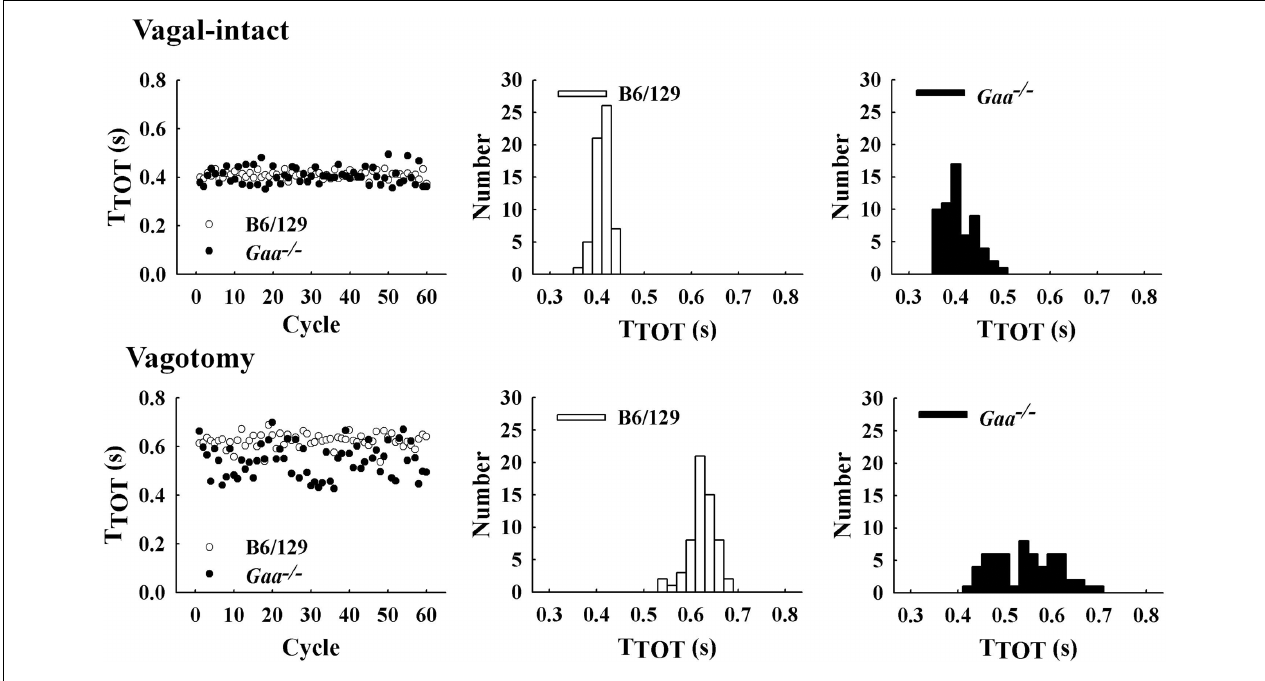
FIGURE 4 | Examples of respiratory cycle variability in representative B6/129 and Gaa − / − mice. The left panel shows a sequential plot of the total duration of the respiratory cycle ( T TOT ) for 60 consecutive cycles. An increase in the breath-to-breath variability in T TOT can be seen in the